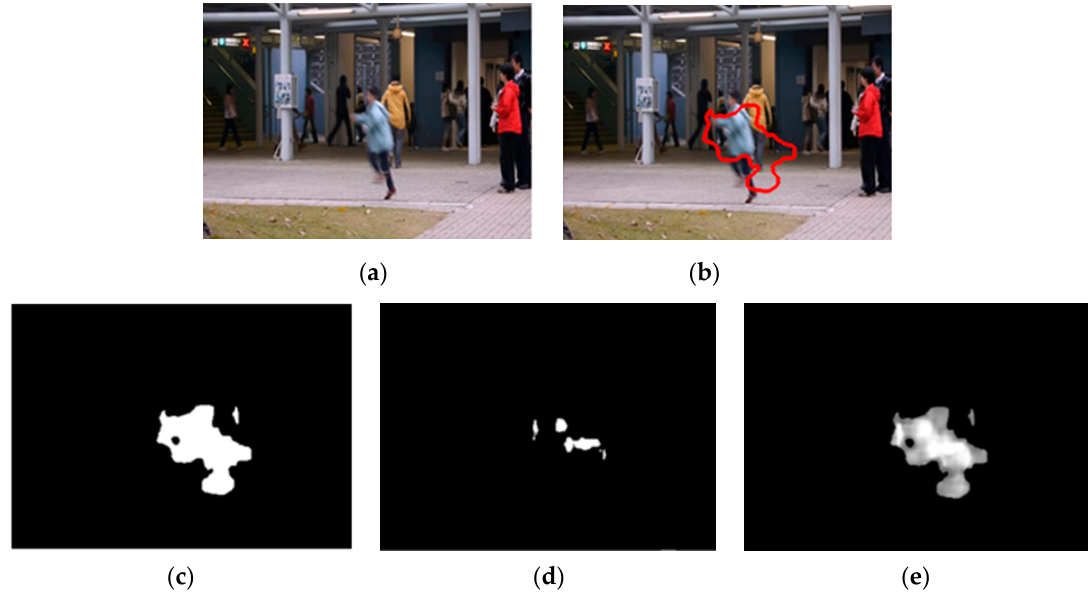
Figure 7. Example result of calculating temporal saliency map. ( a ) original frame; ( b ) result of the system; ( c ) R mag ; ( d ) R grad ; ( e ) temporal saliency map ( TS ) .